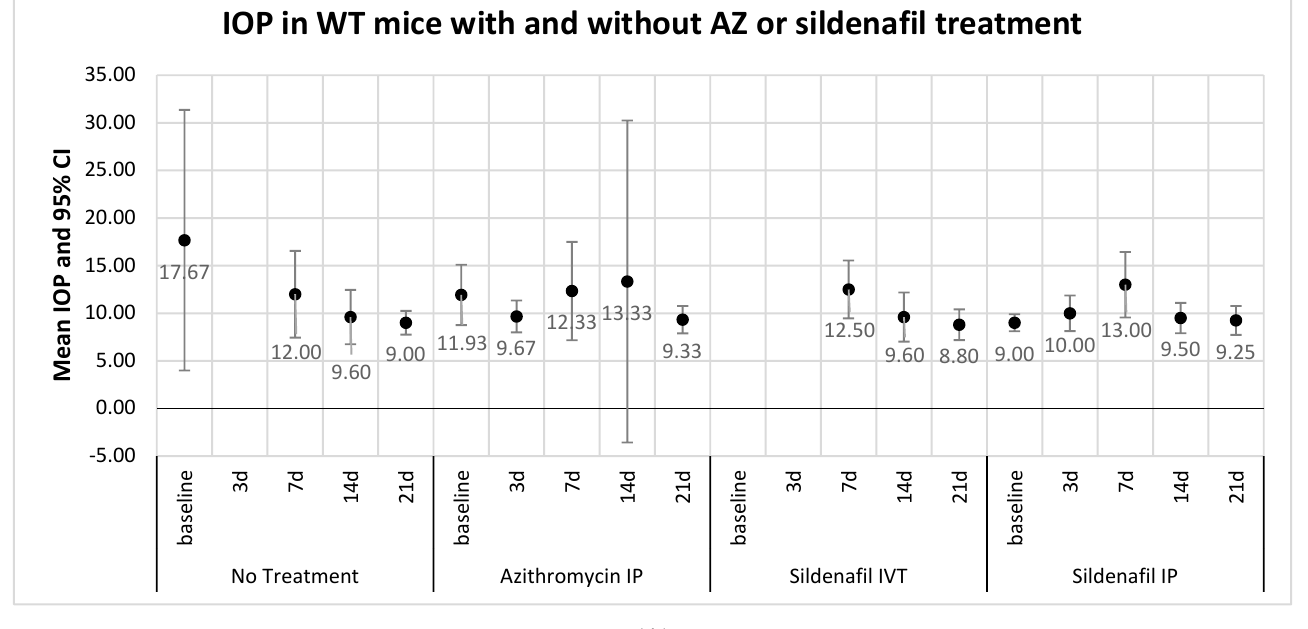
( B ) Figure 2. ( A ) Comparison of IOP measurements between treated and untreated groups: WT mice. Analysis of eyes injected with microbeads and either untreated ( n = 8) or treated with intraperitoneal AZ ( n = 20), intravitreal sildena fi l ( n = 5), or intraperitoneal sildena fi l ( n = 17). The results shown in the fi gure are based on between 3 and 15 eyes for each measurement. IOP decreased in systemic untreated eyes during follow-up. IOP was variable in AZ-treated eyes, peaking at 2 weeks. In sildena fi l-treated eyes, IOP peaked on day 7 and then decreased. IOP, intraocular pressure; IP, in- traperitoneal; IVT, intravitreal. ( B ) Comparison of IOP measurements between treated and un- treated groups: TLR4KO mice. Analysis of eyes injected with microbeads and either untreated ( n = 11) or treated with intraperitoneal AZ ( n = 9). The results of 3–15 eyes for each measurement are shown. IOP increased in AZ-treated eyes on days 3, 7, and